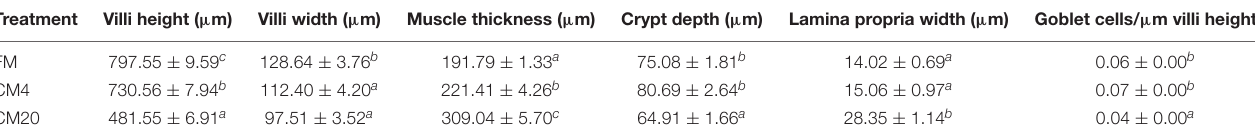
FIGURE 1 | Representative histological evaluation of the distal intestine in hybrid grouper fed the FM (A–C) , CM4 (D–F) , and CM20 (G–I) diets based on Alcian Blue-Periodic Acid-Schiff (AB-PAS) staining. (A,D,E) Shows a decreasing villi height (red arrows) and increased mucosal folds (blue arrows) as replacement levels increases. (B,C,E,F,H,I) Shows the changes in the villi width (yellow arrow), lamina propria (LP), crypt depth (CD), and goblet cells (green arrows). FM, fish meal (control group); CM4, 4% castor meal (CM) protein replacement to FM protein; CM20, 20% CM protein replacement to FM protein. TABLE 3 | The distal intestinal tissue morphology of hybrid grouper fed with experiment